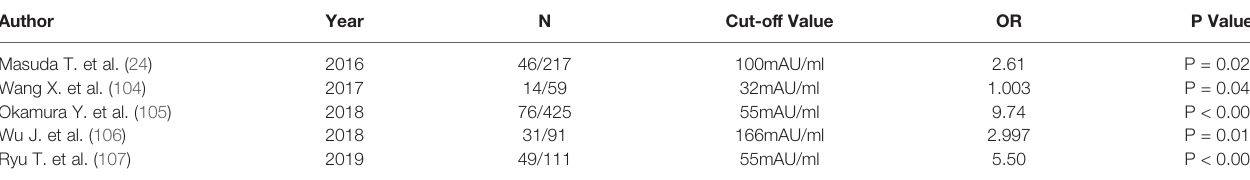
TABLE 2 | Cutoff value of PIVKA-II as an independent predictor in HCC vascular